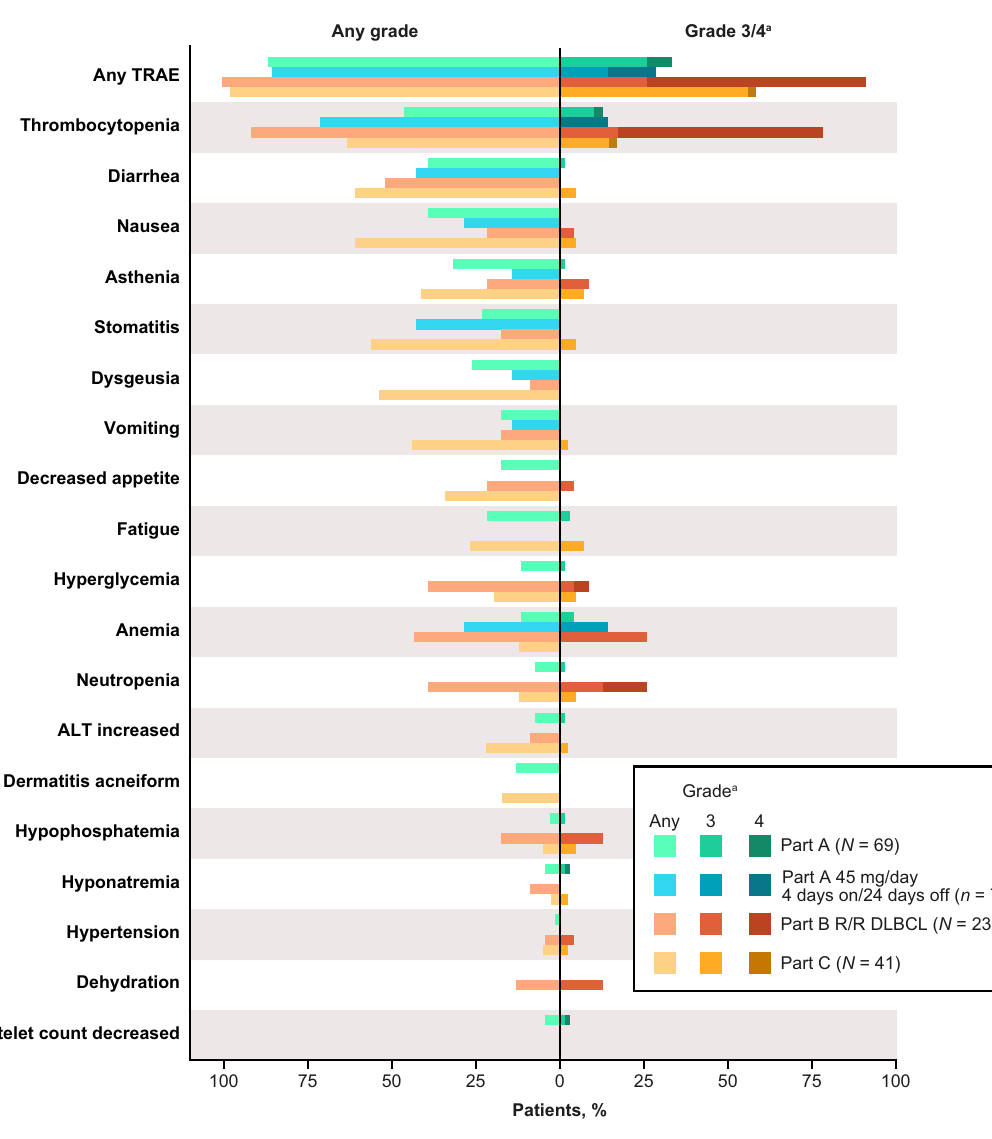
Fig. 2 | Treatment-related adverse events reported in ≥ 10% of patients in the overall study population, or in ≥ 2 patients at grade ≥ 3 severity. Grade